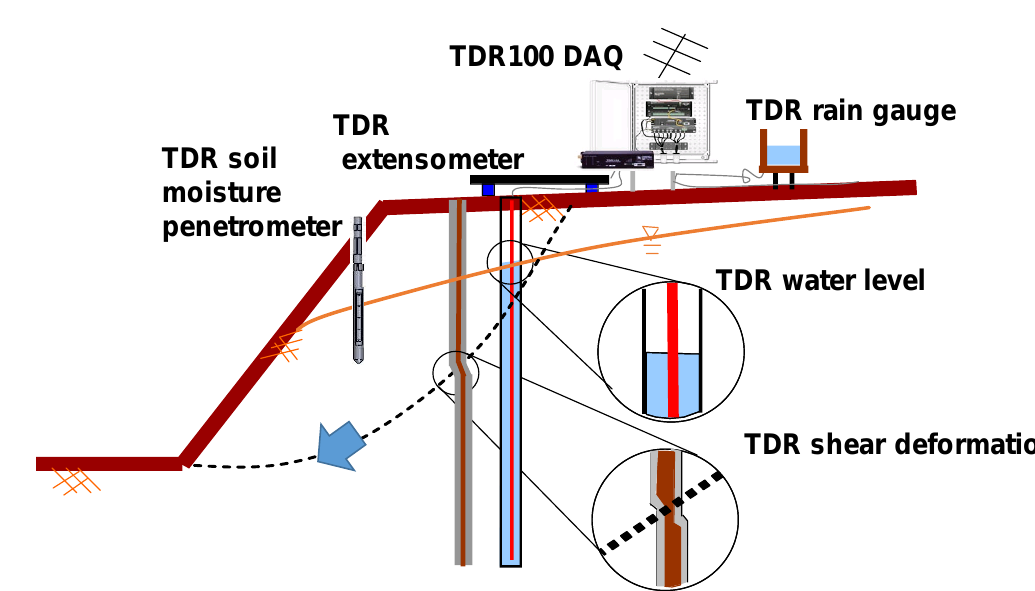
Figure 1. Time-domain reflectometry (TDR) schematic and related sensing waveguides.